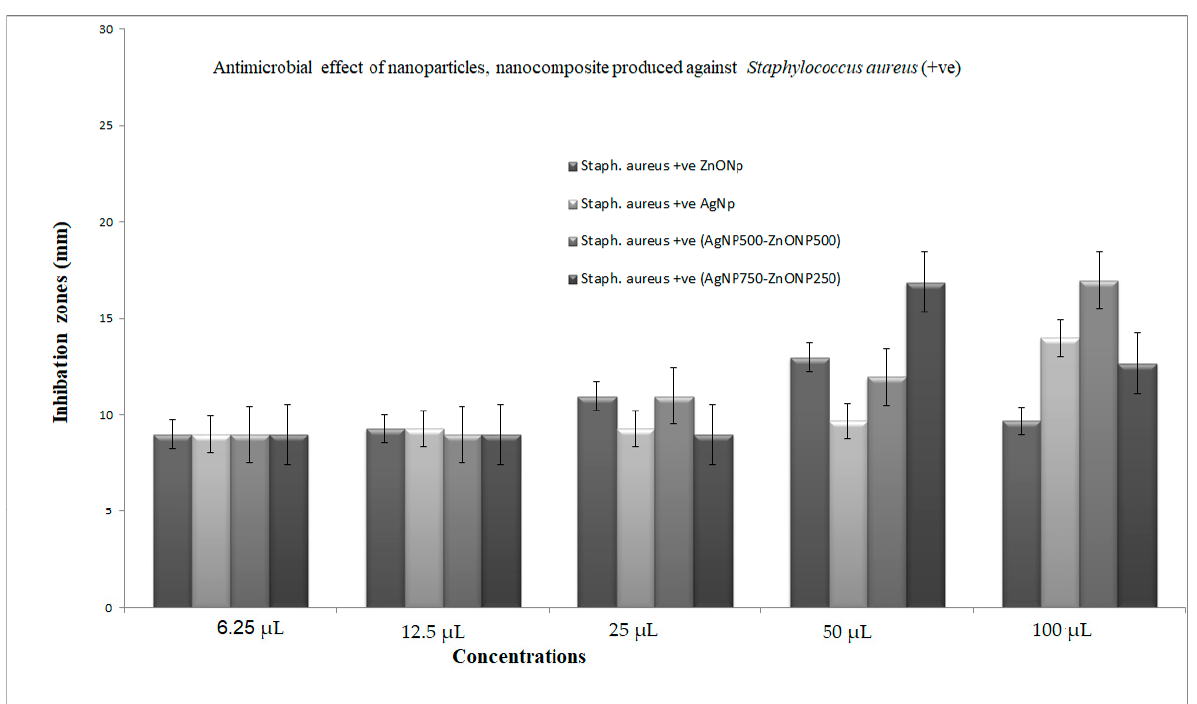
Figure 10. The antimicrobial activity of the nanoparticles and nanocomposite produced against human pathogenic microbe: Staphylococcus aureus . Data showing increasing inhibition zone with increasing amounts of nanoparticles: 6.25, 12.5, 25, 50 and 100 µ L with volume made up to 100 µ L with distilled water wherever needed. Zinc oxide nanoparticles (ZnONPs); silver nanoparticles (AgNPs); composite 500 µ L AgNPs–500 µ L ZnONPs; composite 750 µ L AgNPs–250 µ L ZnONPs nanoparticles. SD ± , standard deviation.